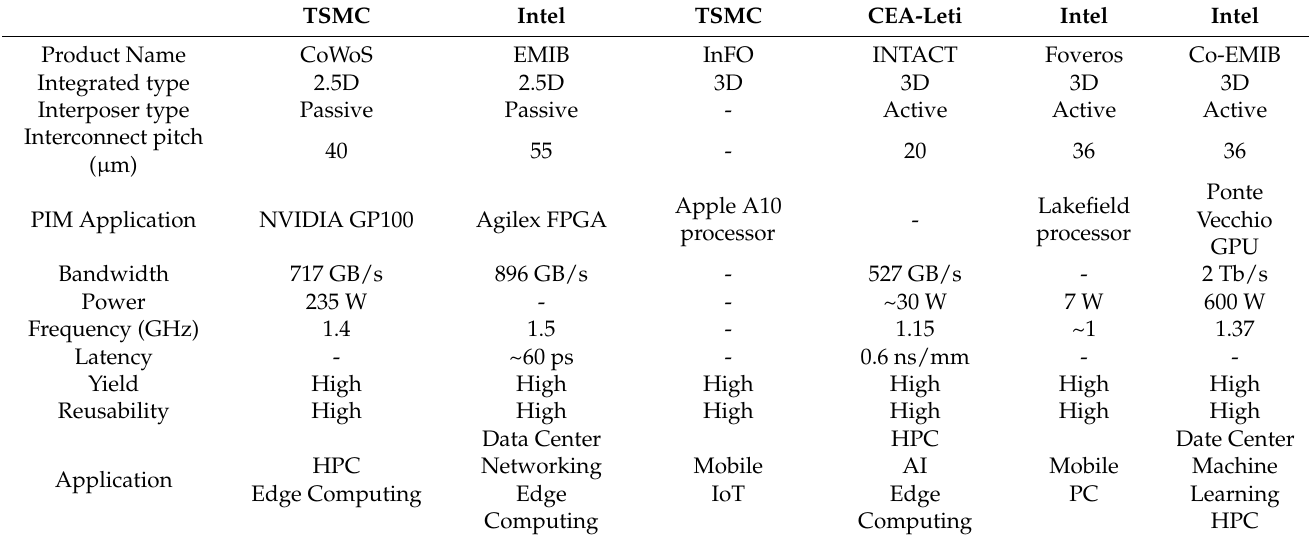
Table 1. Comparison of PIM architectures based on